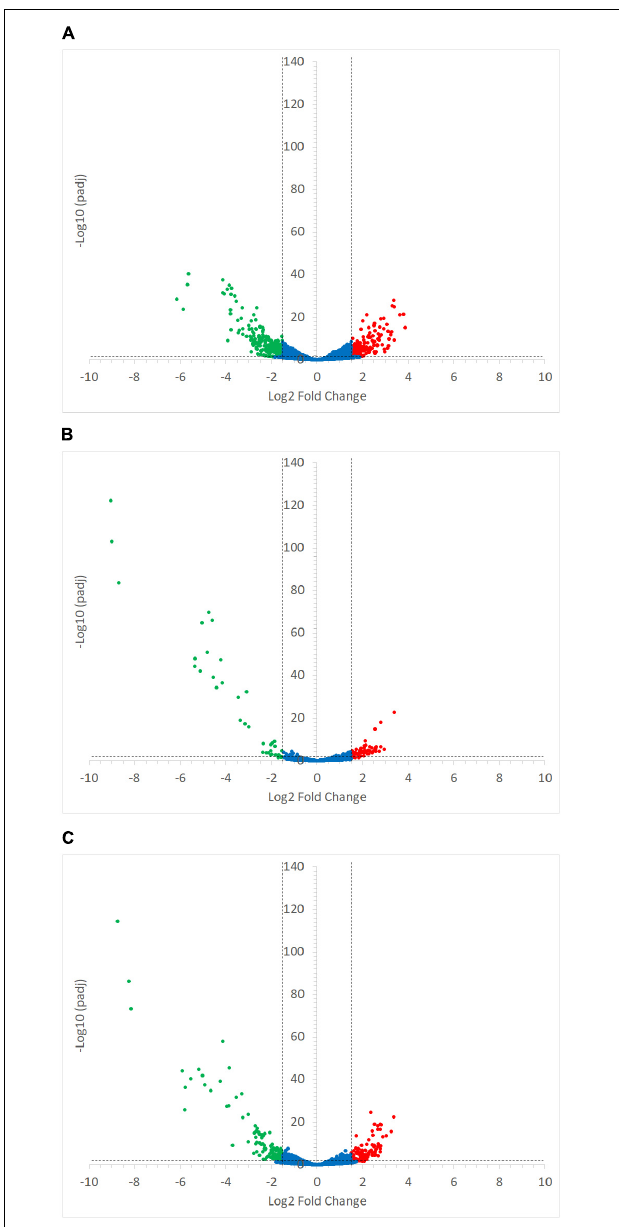
FIGURE 7 | Volcano plots representing the differential expression analysis of R. gnavus ATCC 29149 genes. Genes were considered to be differentially expressed when Log2 Fold Change < –1.5 or > 1.5 and padj < 0.05; non-differentially expressed genes are shown as blue dots. Panel (A) shows the impact of starch type on R. gnavus ATCC 29149 gene transcription when co-cultured with R. bromii L2-63; 213 genes were upregulated in the co-culture with RS (shown as green dots) while 212 genes were up-regulated in the co-culture with SS (shown as red dots). The combined effect of the presence of R. bromii L2-63 and the carbon source (starch vs. glucose) is shown in panels (B) and (C) when SS or RS was used in the co-culture, respectively; (B) When SS was used as carbon source, 40 genes were up-regulated in the co-culture (shown as green dots) and 59 genes were up-regulated in the mono-culture (shown as red dots). (C) When RS was used as carbon source, 119 genes were up-regulated in the co-culture (shown as green dots) while 101 genes were up-regulated in the mono-culture (shown as red